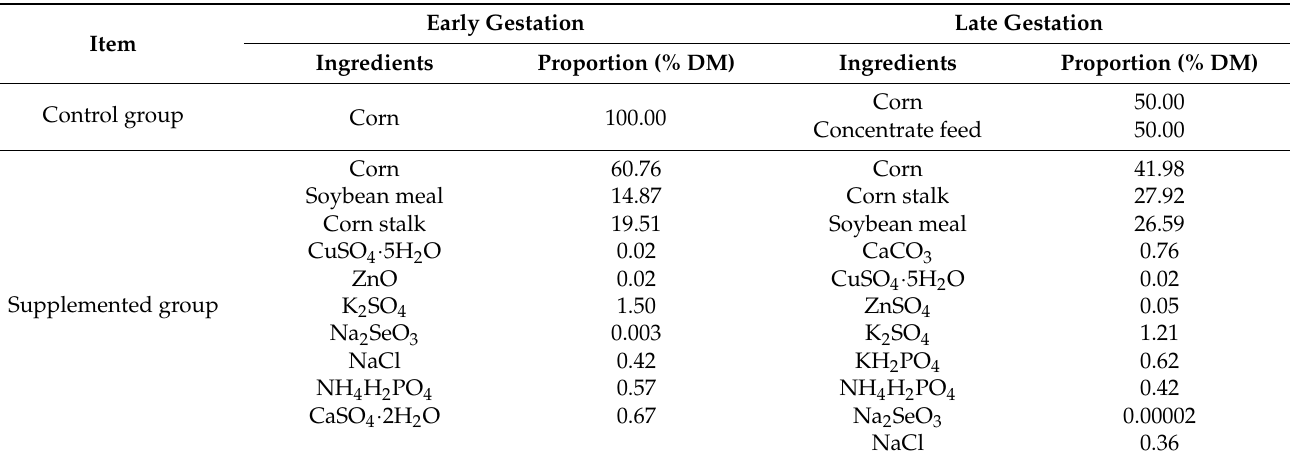
Table 1. Supplementary feed ingredients in early and late